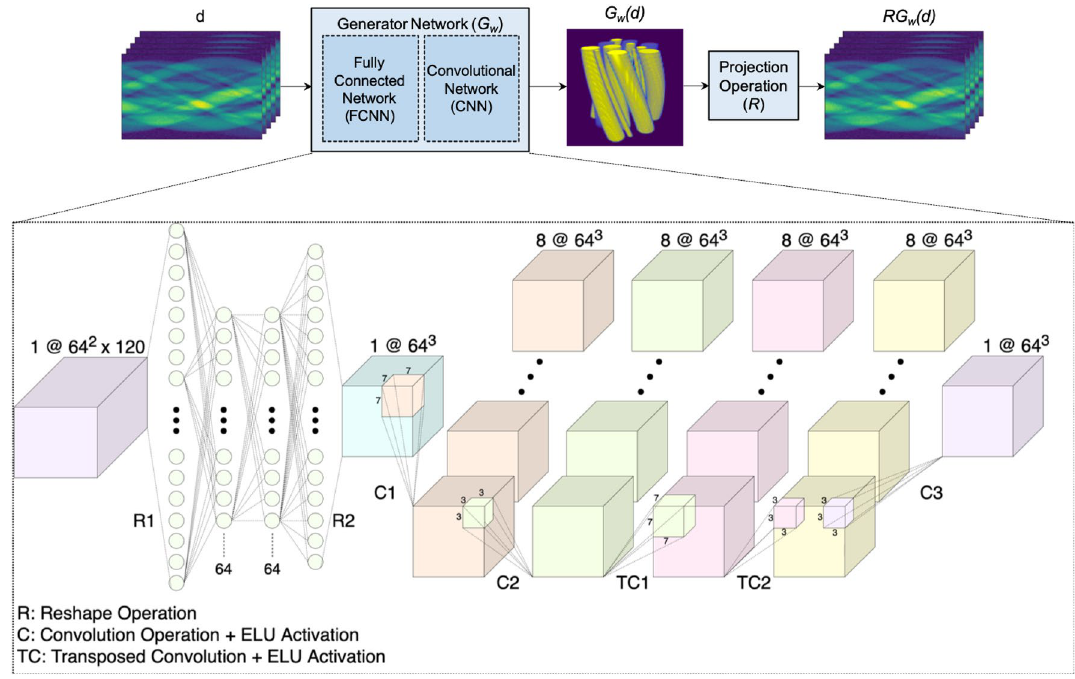
Figure 2. Illustration of the operators and deep neural network architecture 23